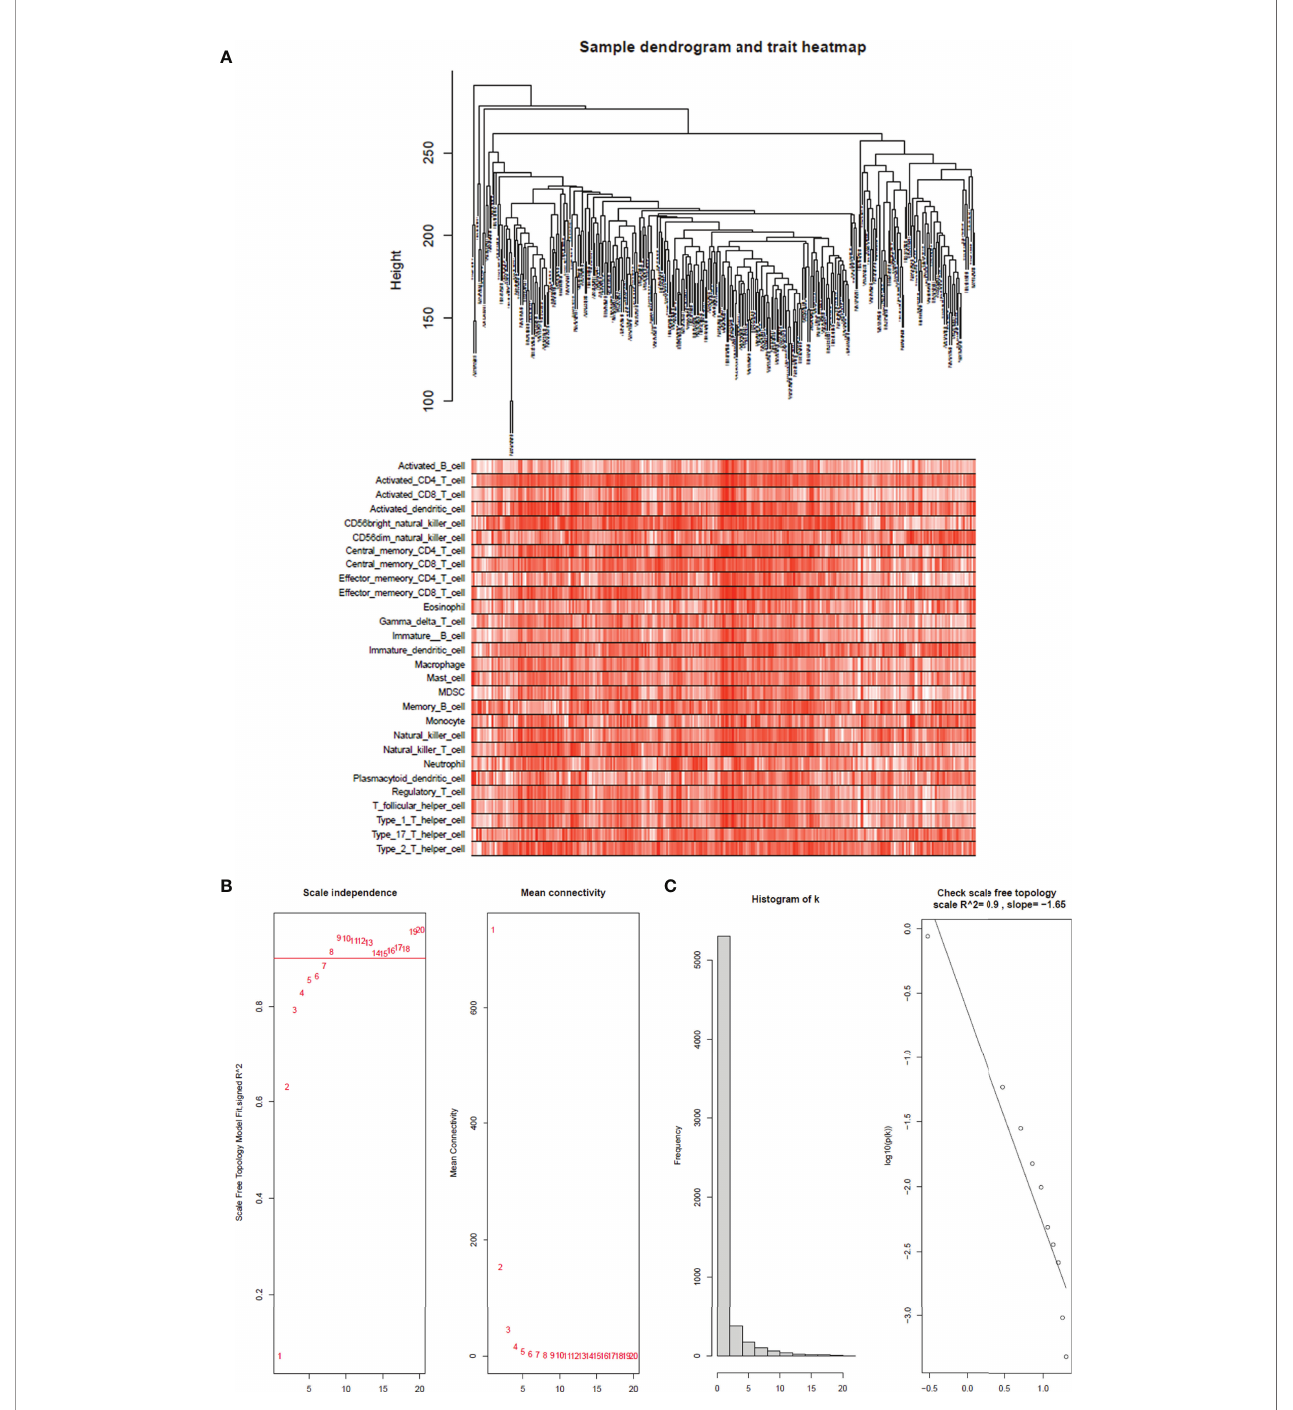
FIGURE 4 | Sample tree and trait heatmap of 28 immune cells. (A) Sample dendrogram and trait heatmap of 28 immune cells. The clinical trait information is immunophenoscores of 28 in fi ltrated immune cells in each sample. (B) Analysis of the scale-free fi t index for various soft-thresholding powers ( b ) and the mean connectivity for soft threshold powers. The soft-thresholding power in the WGCNA was determined on the basis of a scale-free R 2 (R 2 = 0.90). The left panel presents the relationship between the soft-threshold and scale-free R 2 . The right panel presents the relationship between the soft-threshold and mean connectivity. (C) Histogram of connectivity distribution when b = 8 and checking the scale-free topology when b =